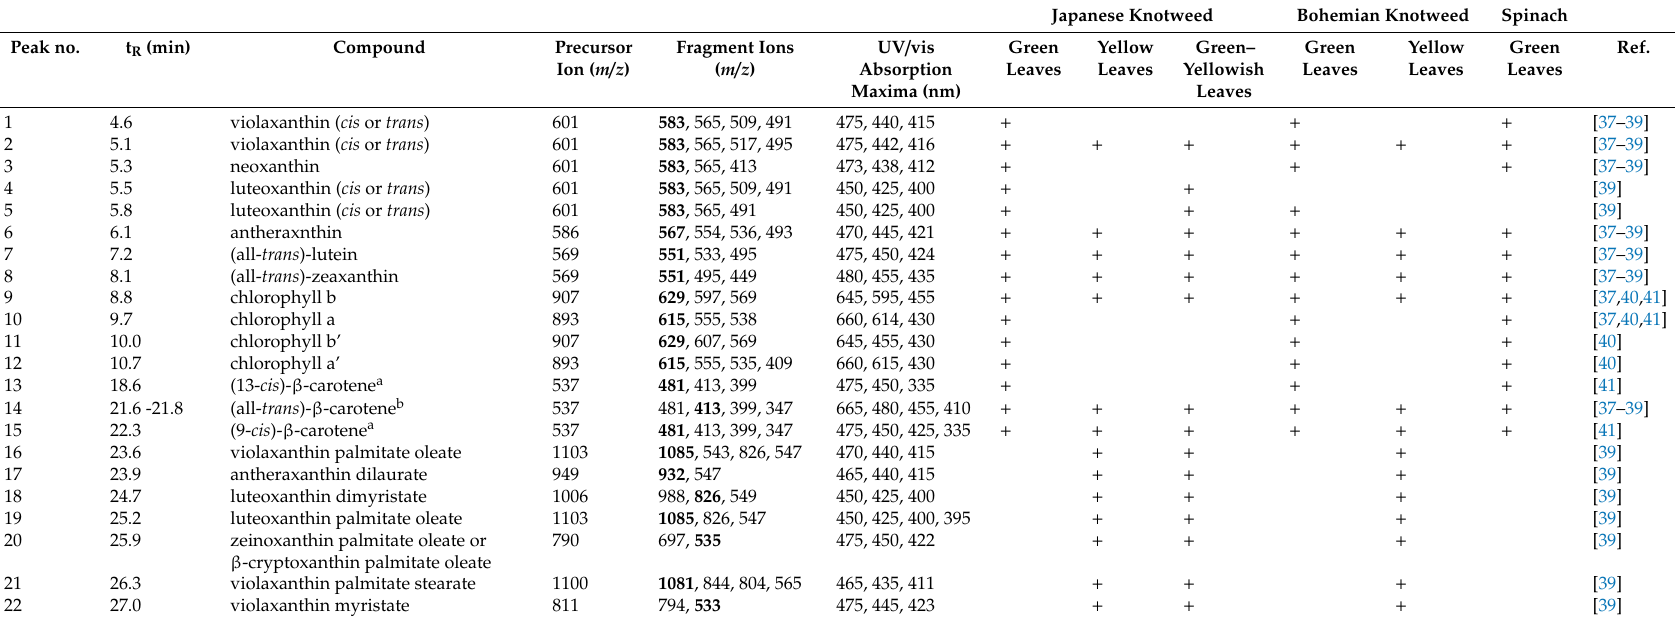
Table 1. Constituents of leaf extracts, identified by HPLC-PDA–MS 2